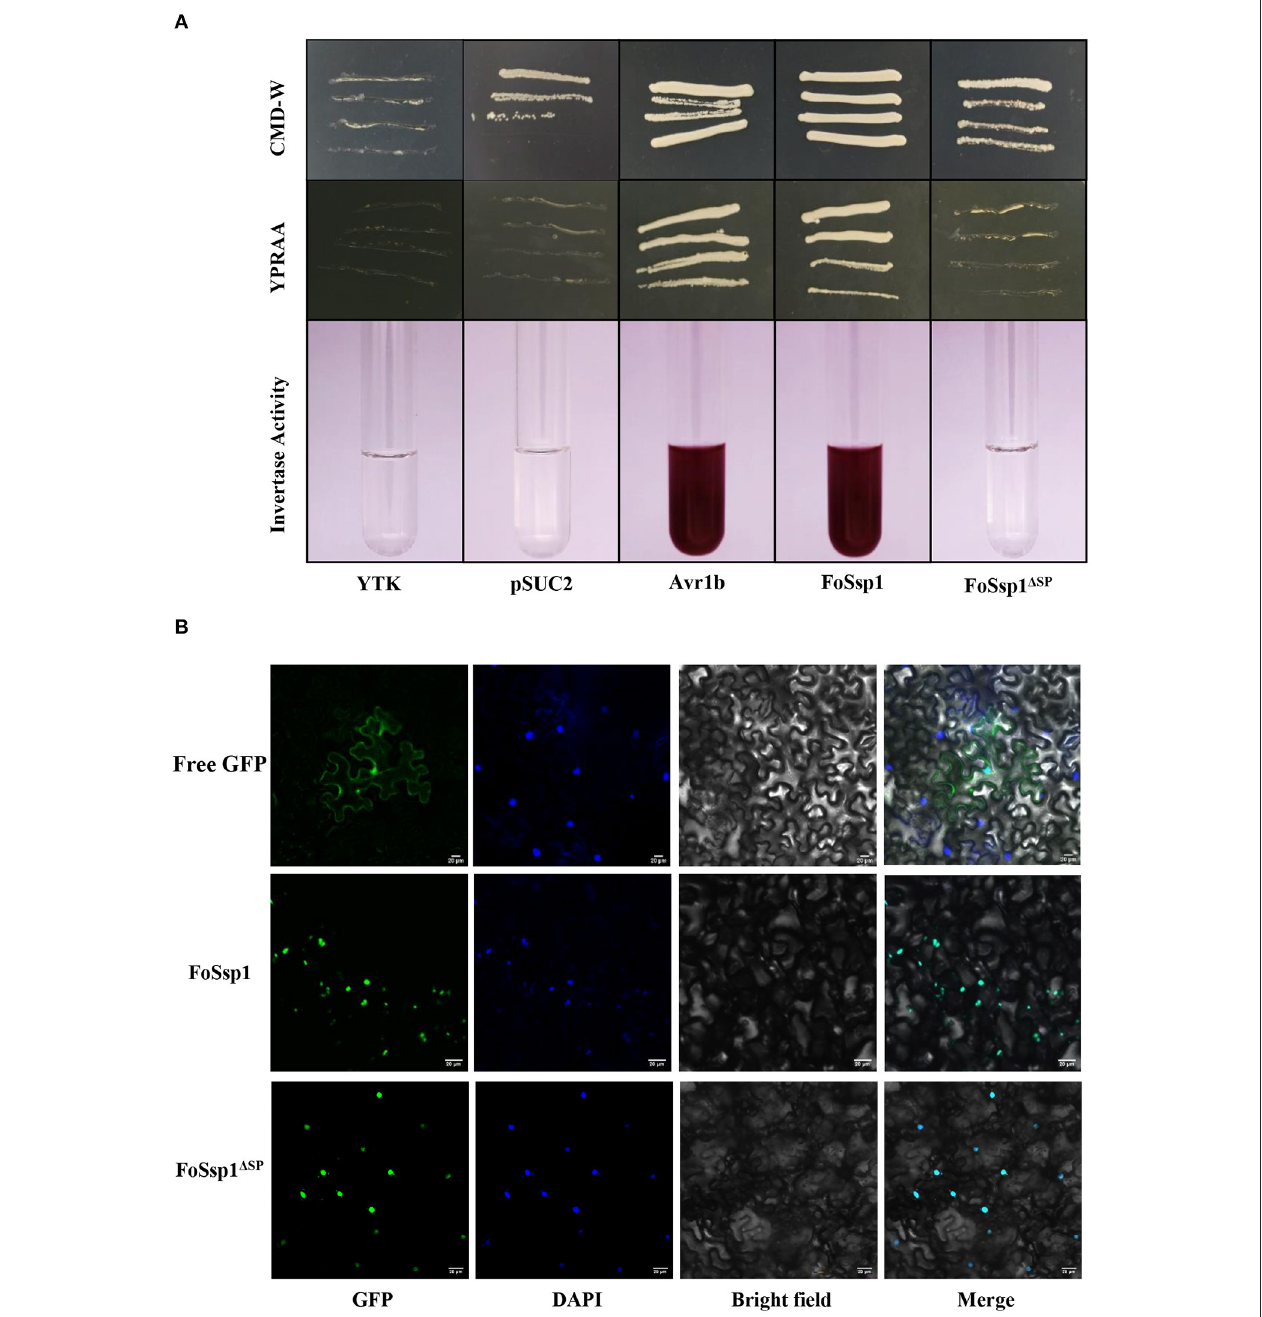
FIGURE 7 | The functional validation of signaling peptide of FoSsp1 and the subcellular localization of FoSsp1 in tobacco epidermal cells. (A) Empty vector pSUC2 was used as negative control, SP sequence of Avr1b from Phytophthora soja was the positive control. The growth of yeast strains in the YPRAA and CMD-W medium were recorded. The change in color put down to the reduction of 2, 3, 5-triphenyltetrazolium chloride (TTC) to insoluble red-colored 1, 3, 5-triphenylformazan (TPF) was monitored. (B) DAPI used plant nuclear staining as nuclear control. The recombinant vector containing green fluorescent protein permeated tobacco leaves mediated by A. tumefaciens . Images were taken 2 days post infiltration. Bars, 20 µ m. All experiments were repeated at least three